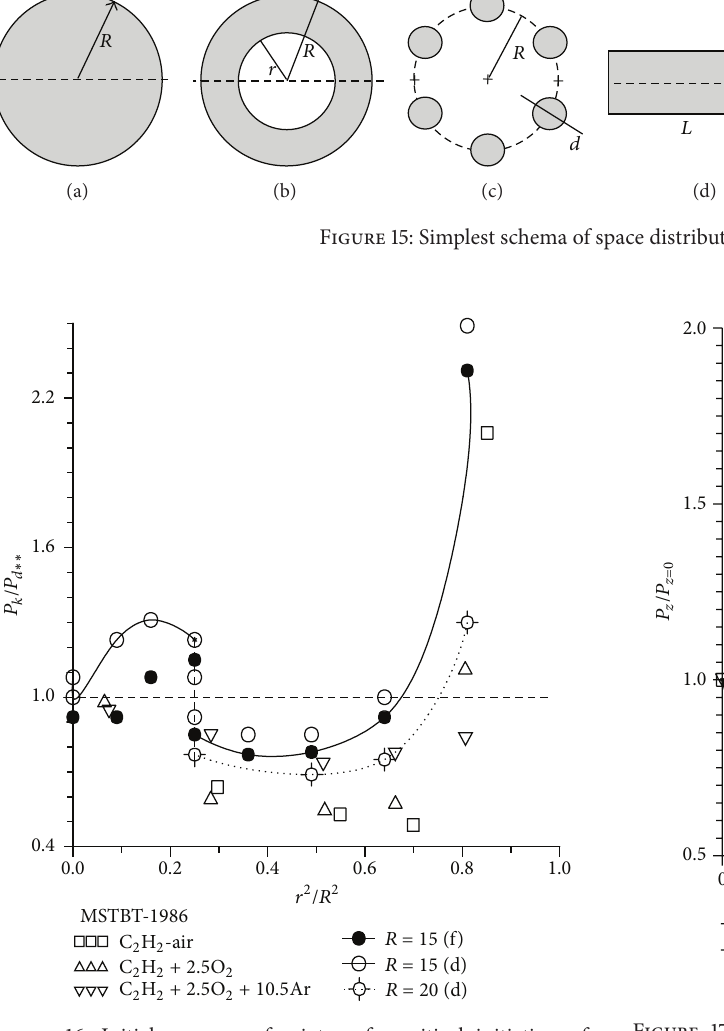
Figure 16: Initial pressure of mixture for critical initiation of quasispherical DW by annular charge Figure 15(b) (normalized on pressure for ring charge of the same diameter Figure 15(a)) on blockage ratio (relation among inner and external radii of annular charge).